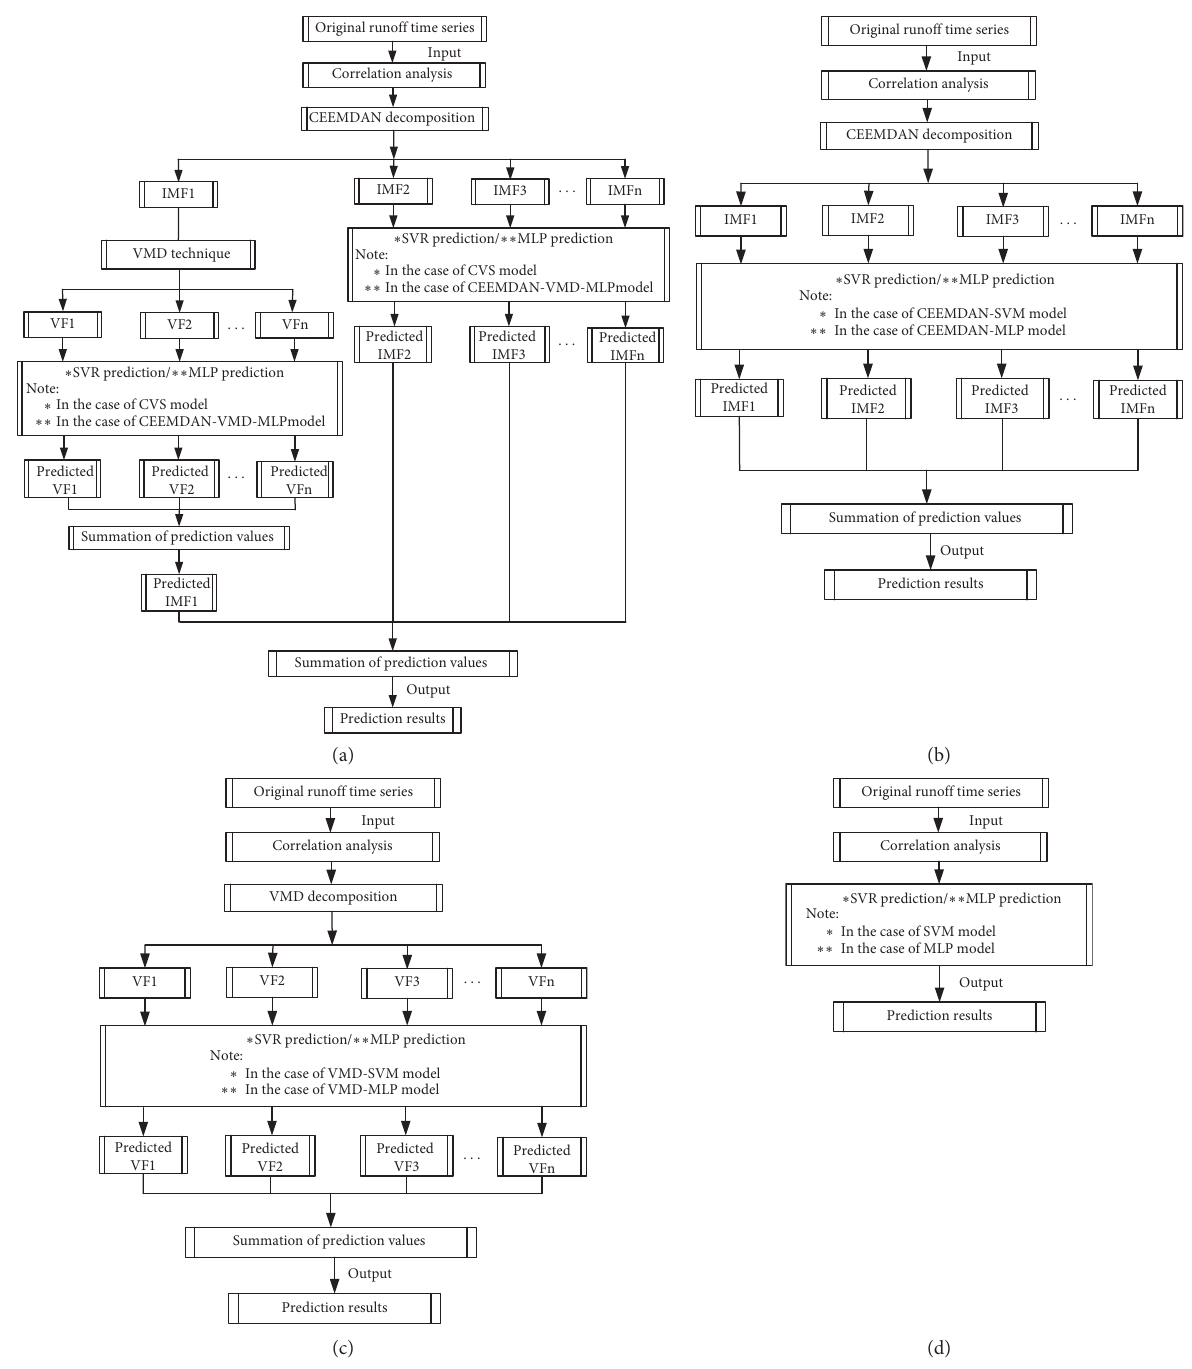
Figure 2: Flowcharts of different models. (a) CVS/CEEMDAN-VMD-VLP model. (b) CEEMDAN-SVM/CEEMDAN-MLP model. (c) VMD-SVM/VMD-VLP model. (d) SVM/MLP